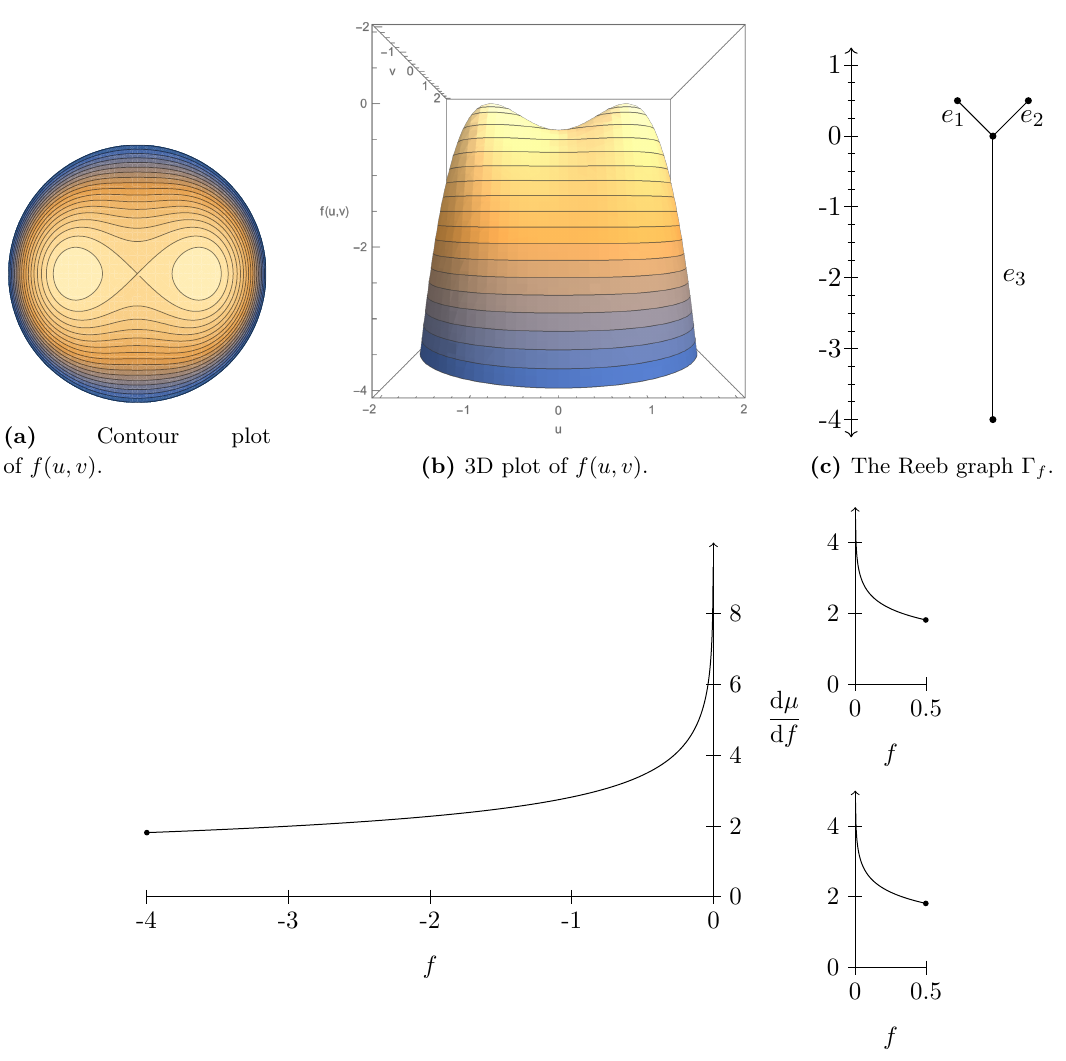
the right are the measures on e 1 and e 2 (which are equal by symmetry). Figure 1. An example function f (3.19), its Reeb graph, and the measure on the Reeb